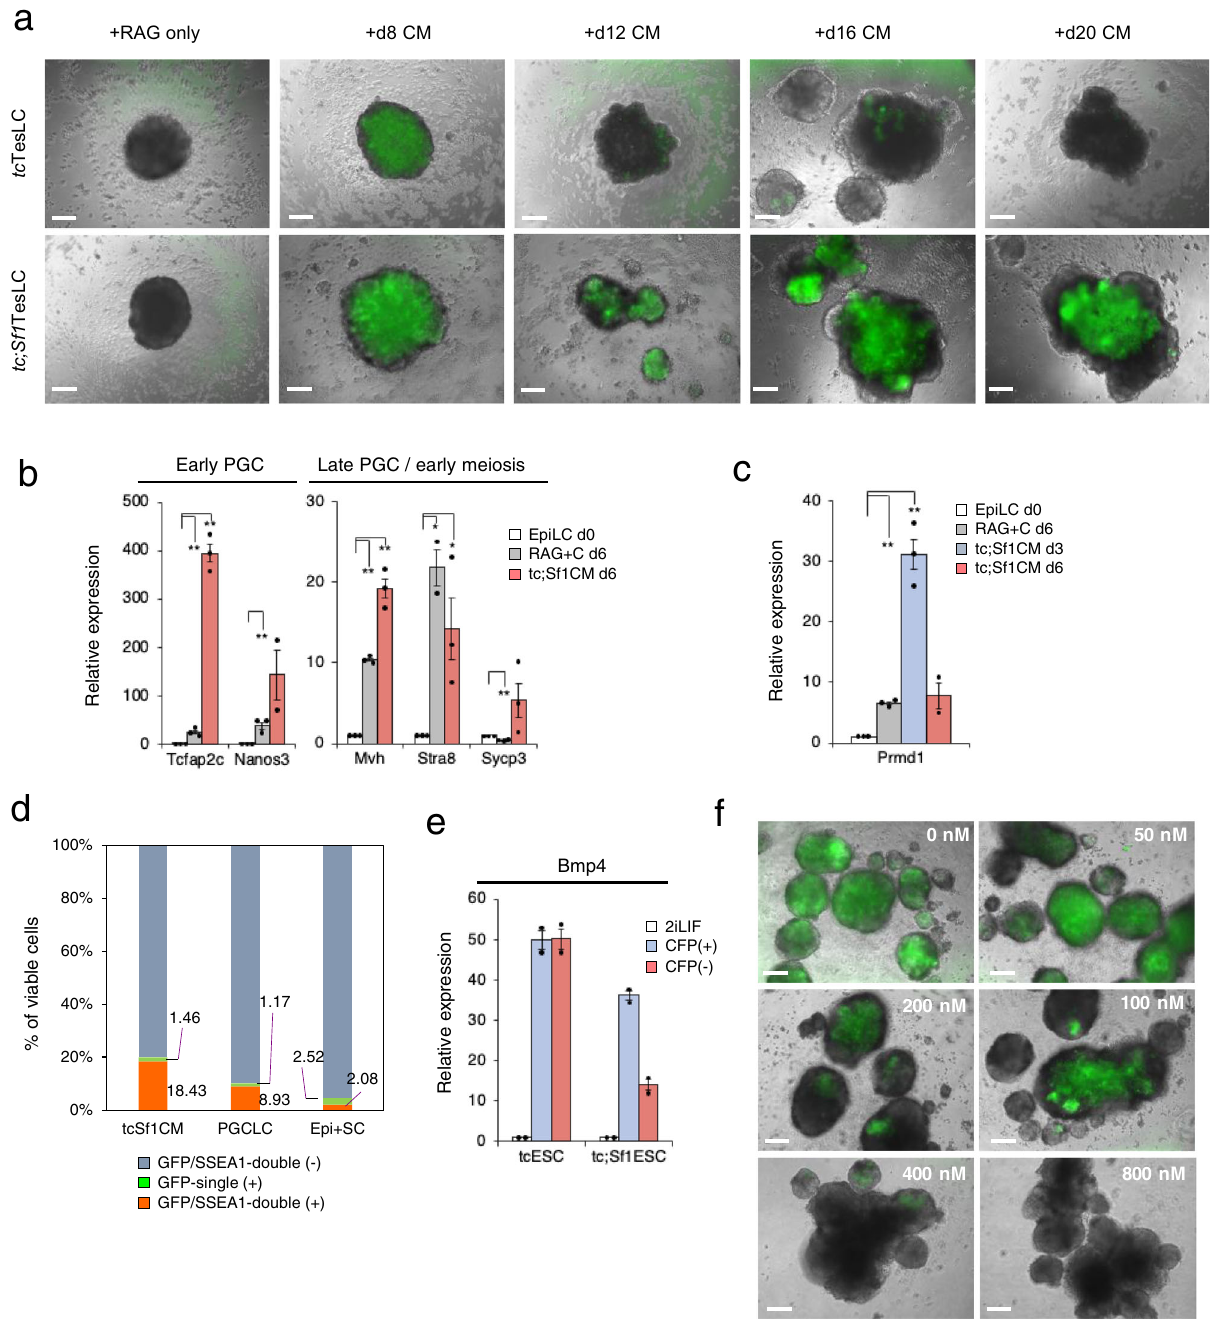
Fig. 4 The effect of TesLC-conditioned medium on induction of EpiLCs to PGCLCs. a PGCLC appearance after administration of conditioned media (CM) derived from CBF-treated tc TesLCs (top panels) and tc;Sf1 TesLCs (bottom panels) with different durations of CBF-treatment. As a negative control, RAG medium only was used. Scale bar, 200 μ m. b , c Relative expression of germ cell markers as indicated in EpiLCs treated with d8 tc;Sf1 TesLCs ( tc;Sf1 CM) for 6 days, compared to parental EpiLCs at day 0 of culture, was calculated by ΔΔ Ct method with standard error. Three biological replicates, each of which had three technical replicates, were used for two-sided t -test. ** P < 0.01, * P < 0.05. d Higher ef fi ciency of PGCLC induction by tc;Sf1 CM, compared with that by the standard protocol (PGCLC) or EpiLC + SCLC co-culture (Epi + SC). Flow cytometry analysis with GFP and SSEA1-PE antibody was performed at day 6 of culture. The percentages of viable GFP/SSEA1 double- positive, GFP-single positive, and both negative cells are displayed. n = 4 biological replicates. e Relative expression of Bmp4 in sorted CFP-positive SCLCs and CFP-negative cells, compared to ESC maintained in 2iLIF medium. n = 2 technical replicates. f Reduction of the number of PGCLCs by administration of LDN-193189 in a dose-dependent manner. Scale bar, 200 μ E12.5SCs revealed that ‘ cytoplasmic components ’ , ‘ intracellular SCLCs, whereas DNA/RNA metabolism and mitochondrion with transport ’ , and ‘ apoptosis ’ were overexpressed in SCLCs, whereas underexpression. These enriched gene sets were also consistent in ‘ ion channel ’ , ‘ axon ’ and ‘ dendrite ’ as well as ‘ neuron ’ and ‘ neu- the comparisons between tc ESCs and E12.5SCs and tc;Sf1 ESCs rogenesis ’ were underexpressed. and E12.5SCs. Finally, the comparison between SCLCs and